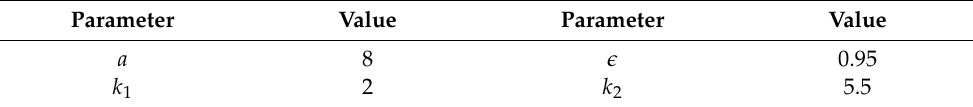
Table 4. Design parameters for